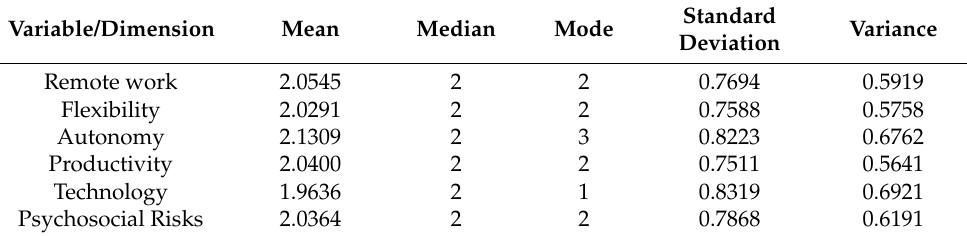
Table 17. Measures of central tendency and dispersion of the variable and its